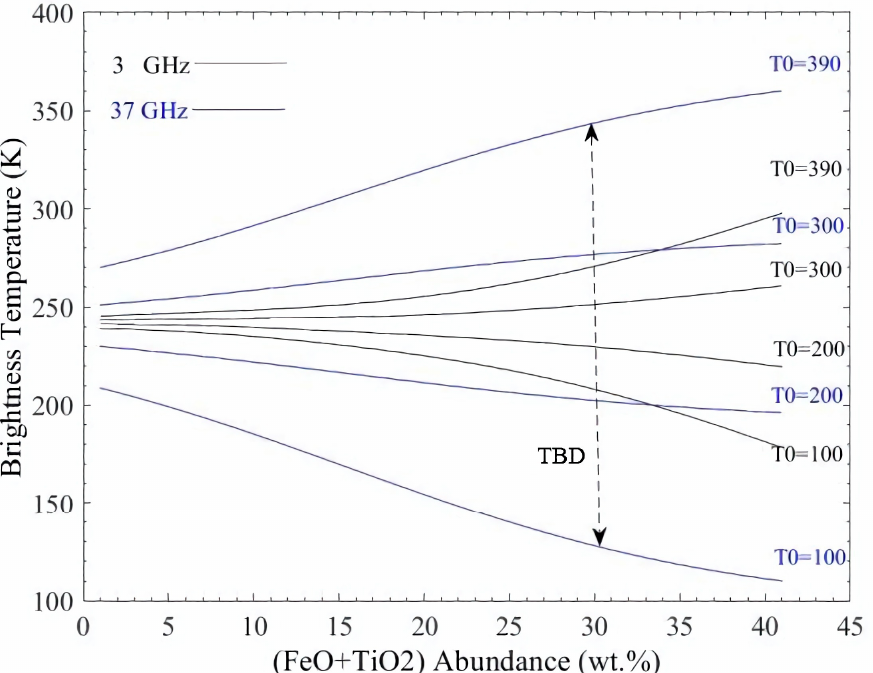
Figure 8. Change in simulated TB with (FeO + TiO 2 ) abundance and surface temperature [34,35]. T0 is the supposed surface temperature (unit: K), which is given as 390 K and 300 K (typical daytime temperatures) and 200 K and 100 K (typical nighttime temperatures).